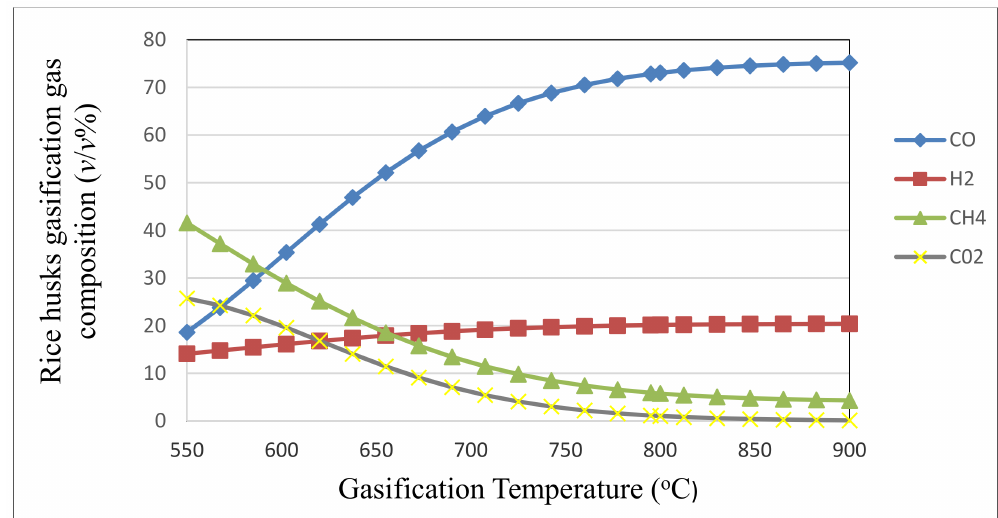
Figure 4. Effect of temperature on the syngas composition simulated results of air gasification of rice husks in Aspen Plus (free of H 2 O and N 2